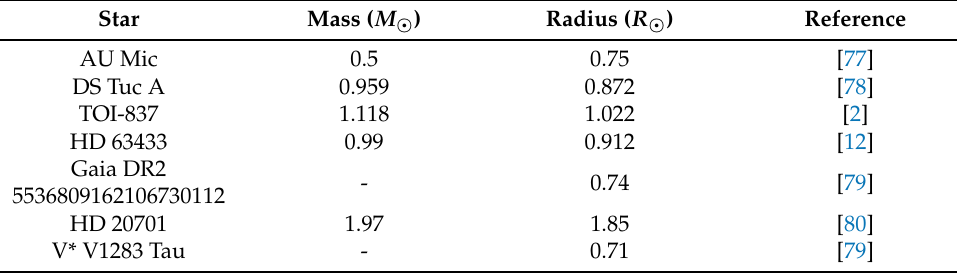
Table 4. Properties of possible planet host